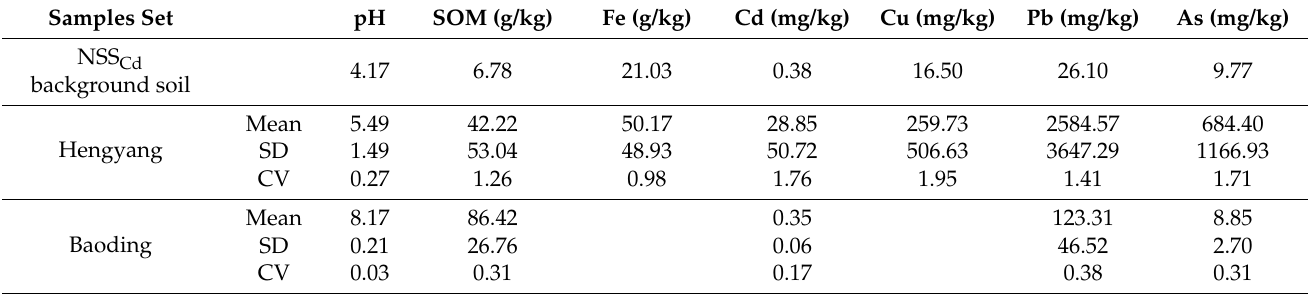
Table A1. pH value and constituents of NSS Cd background soil and